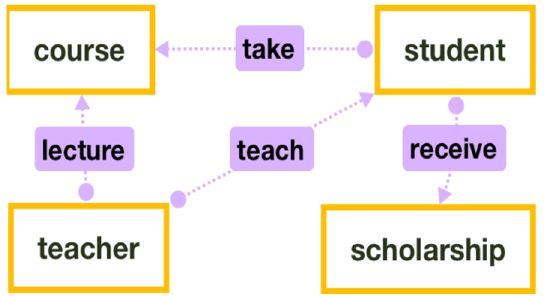
Figure 2. schema A extracted from Figure 1. Figure 2. Schema A extracted from Figure